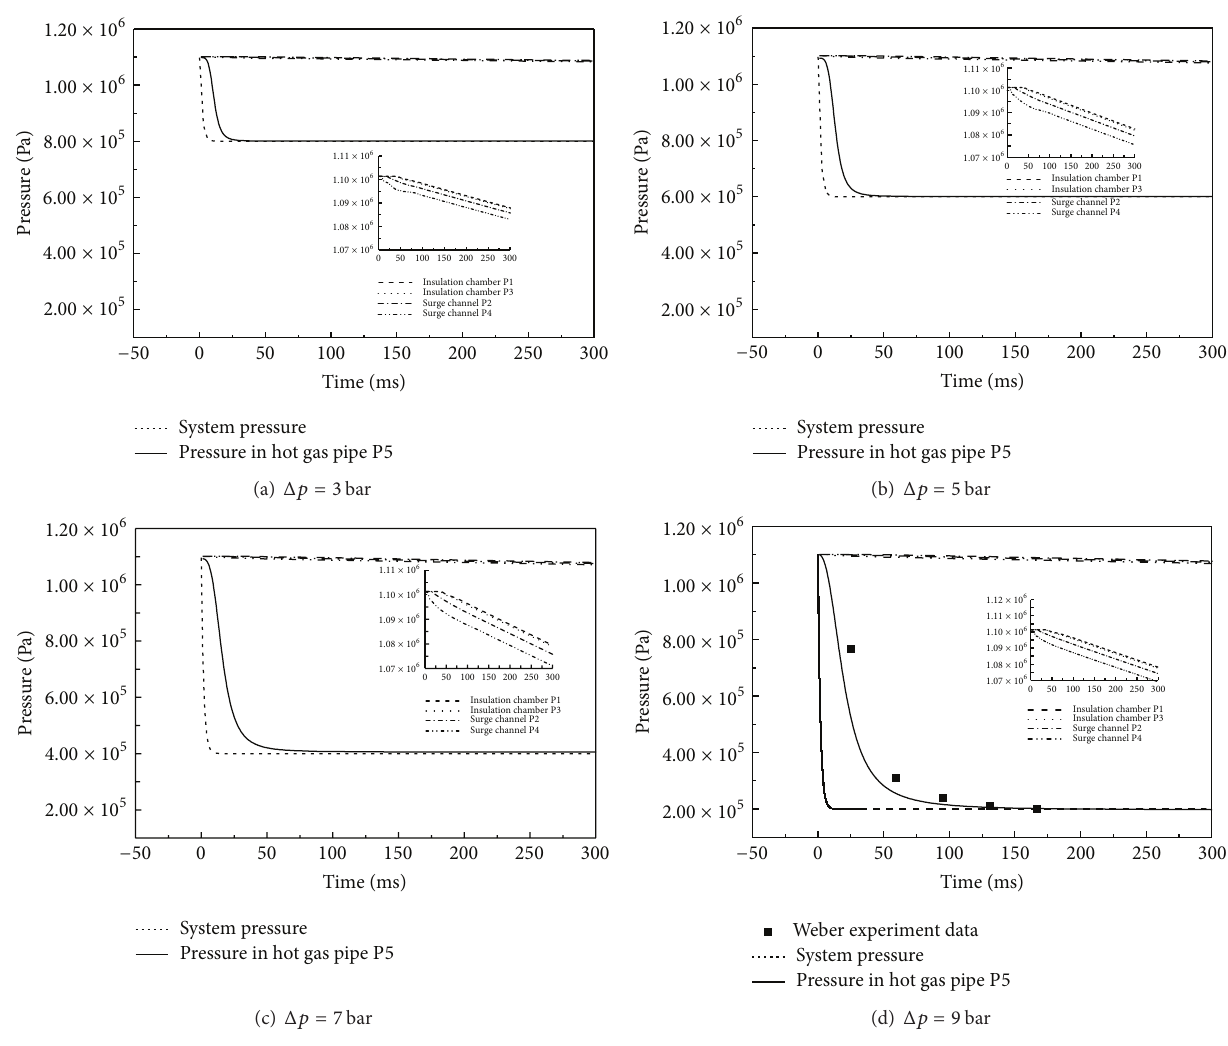
Figure 4: Pressure transient in hot gas